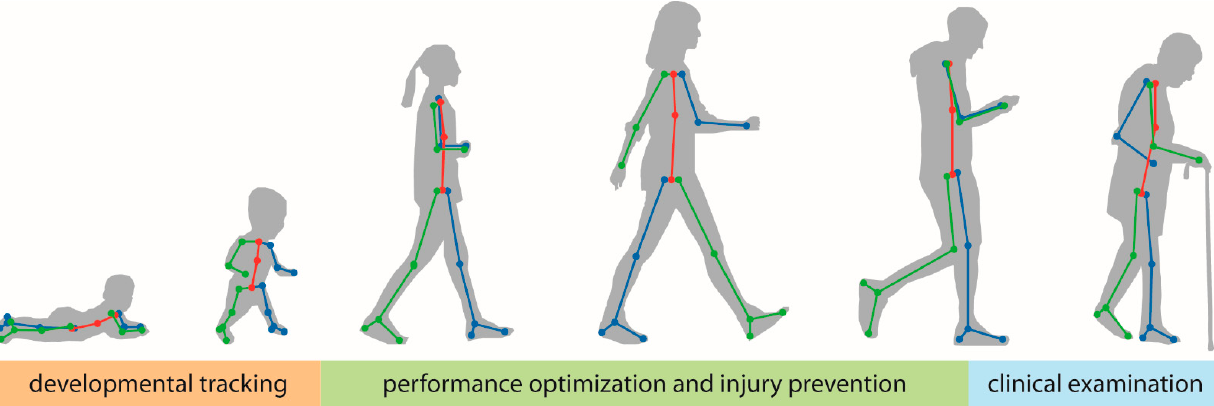
Figure 2. In this manuscript, we focus on three general areas of applications of pose estimation in human health and performance across the lifespan: tracking of motor and non-motor development in young children (orange), performance optimization and injury prevention in athletes and other populations that are primarily young or middle-aged adults (green), and clinical examinations of persons with neurologic damage or disease who are primarily older adults (blue).